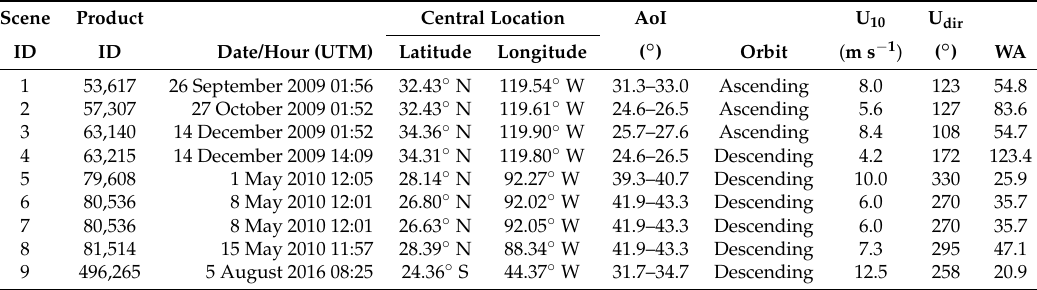
Table 1. RadarSAT-2 data set and meteo-oceanographic